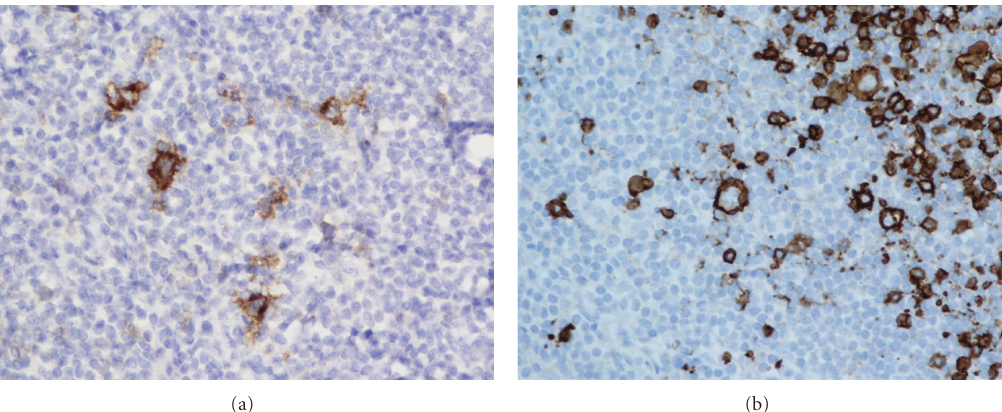
Figure 3: (a) Immunohistochemistry stain showing RS cells positive for CD30 (magnification 40x). (b) Immunohistochemistry stain showing RS cells positive for CD20 (magnifications 40x).